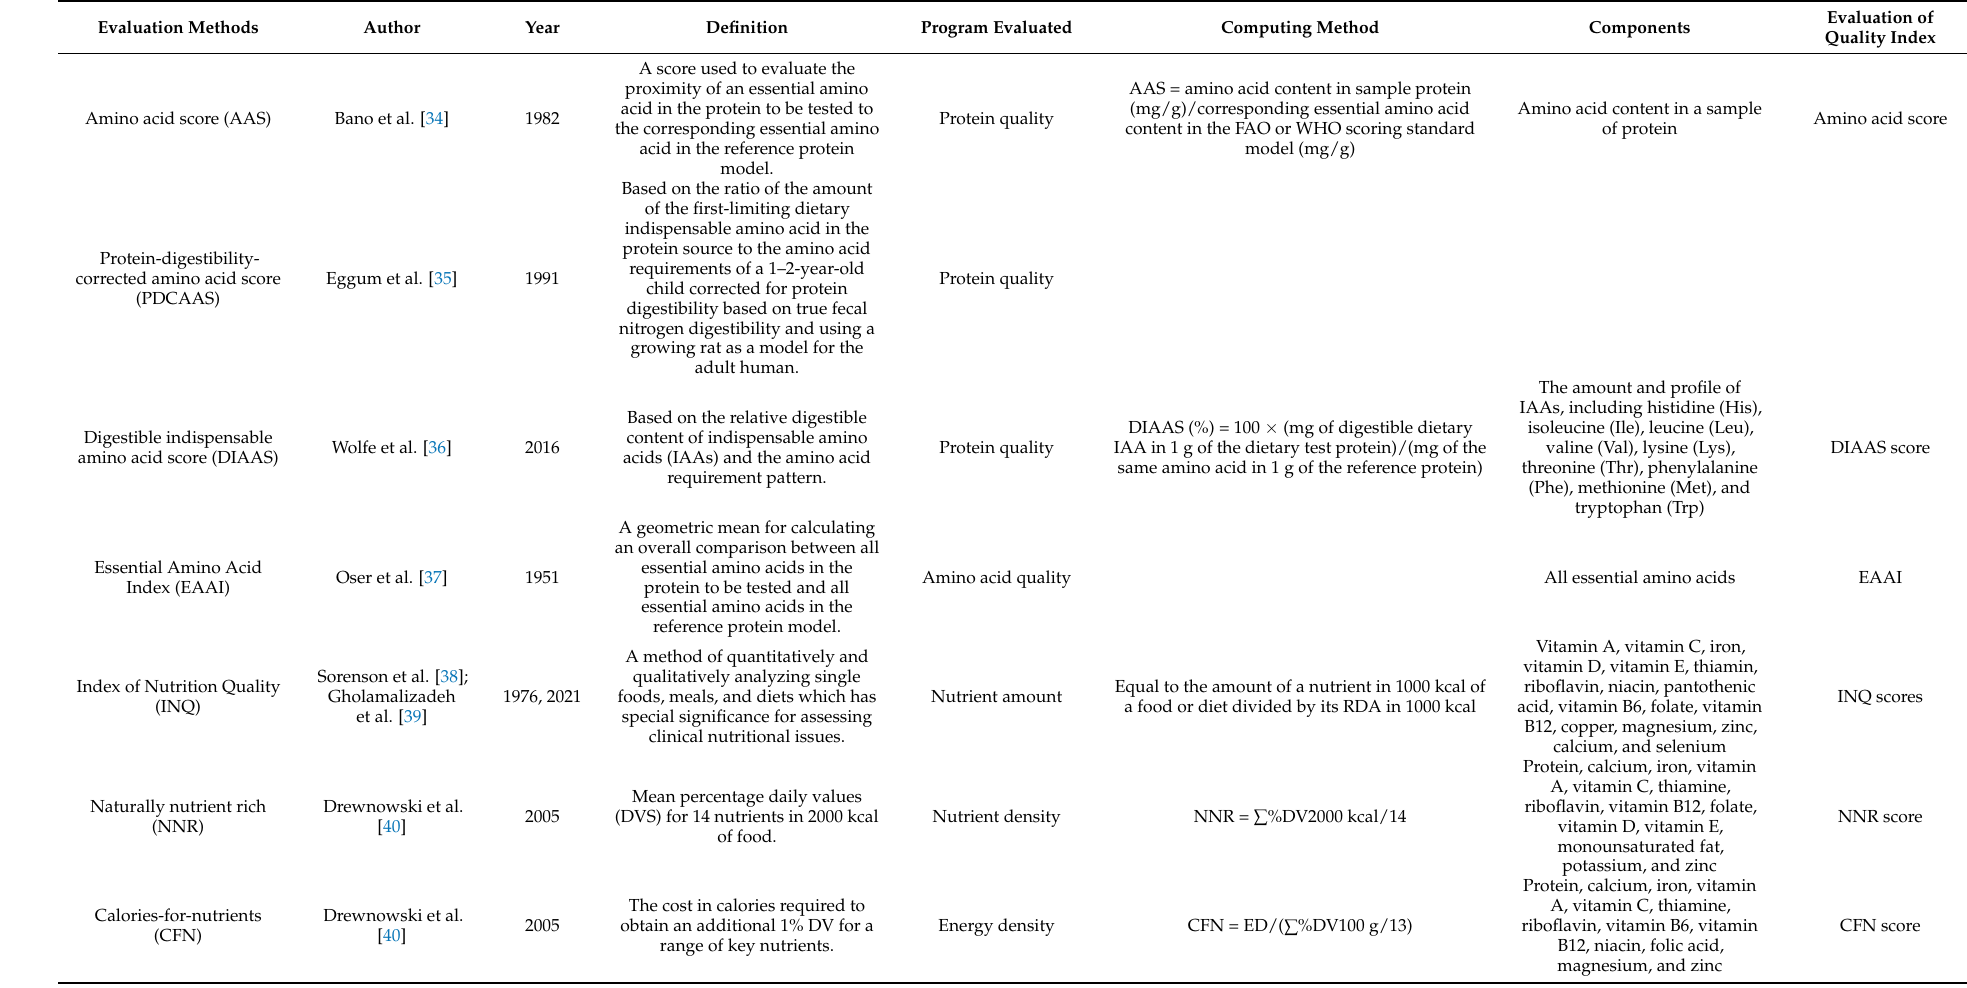
Table 1. Common methods for evaluating the nutritional value of